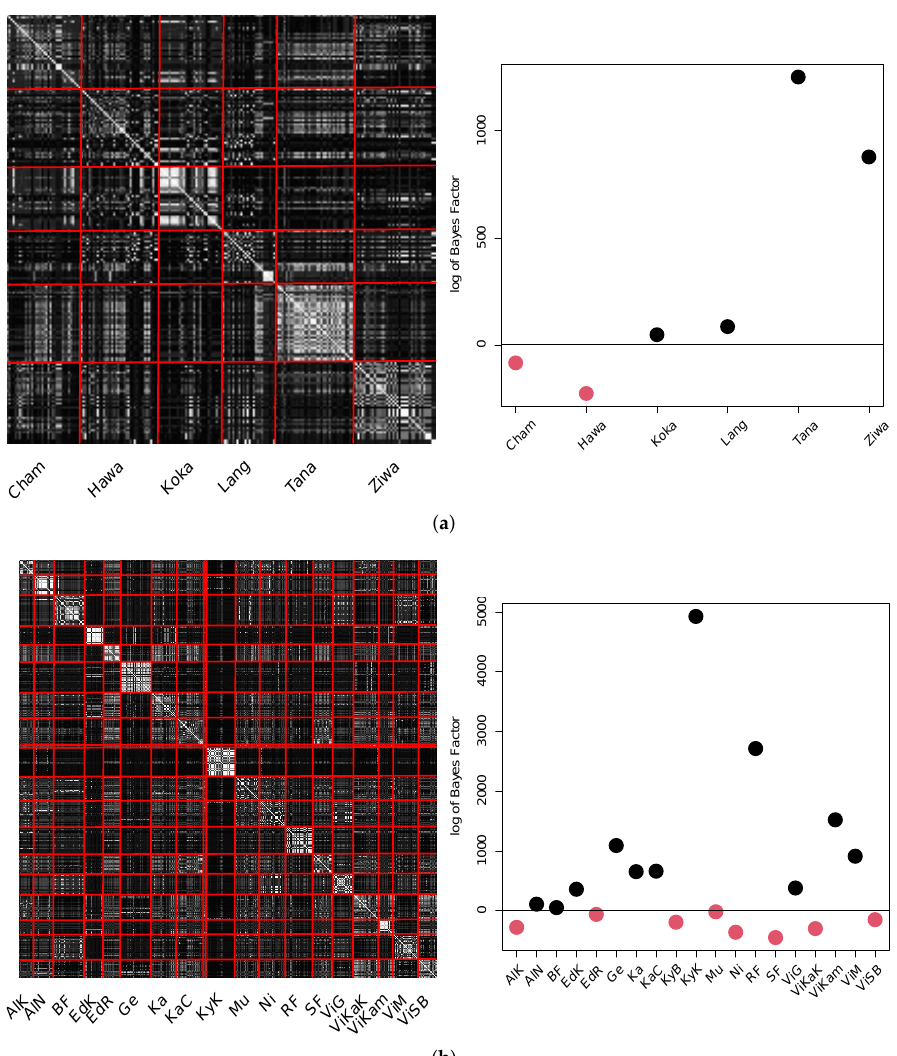
Figure 14. Visualization of the results obtained by pCA and the Bayes factor hypothesis test relying on GP-LVM. Both pCA matrices show visible structure. Four of six locations in Ethiopia were found to be significantly different to the remaining locations. Eleven out of nineteen locations were identified to be significantly different in Uganda’s locations. ( a ) pCA and Bayes factor results for Ethiopia relying on GP-LVM. ( b ) pCA and Bayes factor results for Uganda relying on GP-LVM. The KyB population label in the pCA matrix was removed due to